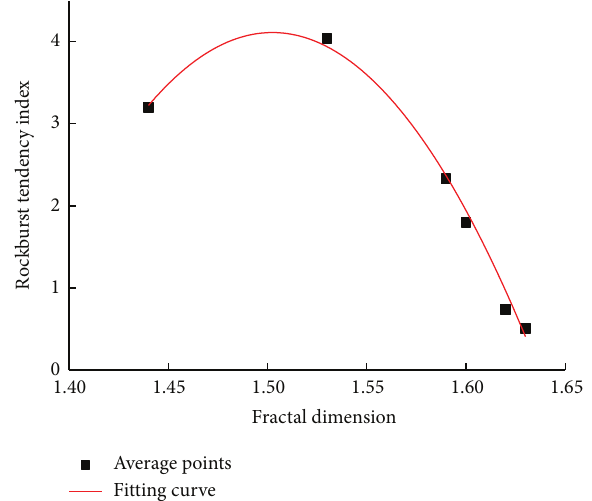
Figure 6: Changes in rockburst tendency index with fractal dimen- sion of fracture